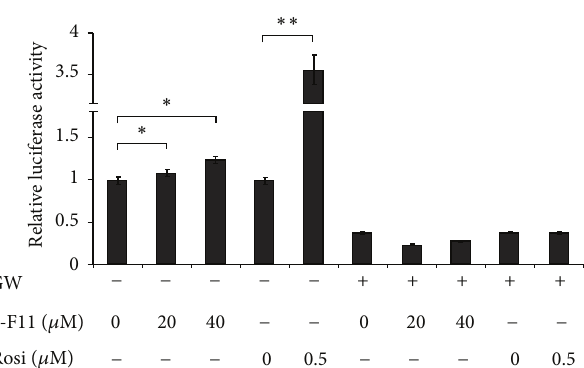
Figure 3: p-F11 exhibits PPAR 𝛾 -activating activities in 293T cells. 293TcellsweretransfectedwithPPRE-TK-Luciferasereporteralong with PPAR 𝛾 and RXR 𝛼 expression vectors for 24 hours. The cells were treated with p-F11 or Rosi in the presence or absence of GW9662 for another 24 hours. The cell extracts were subjected to luciferase assay. The results were presented as a percentage of the control (p-F11 0 𝜇